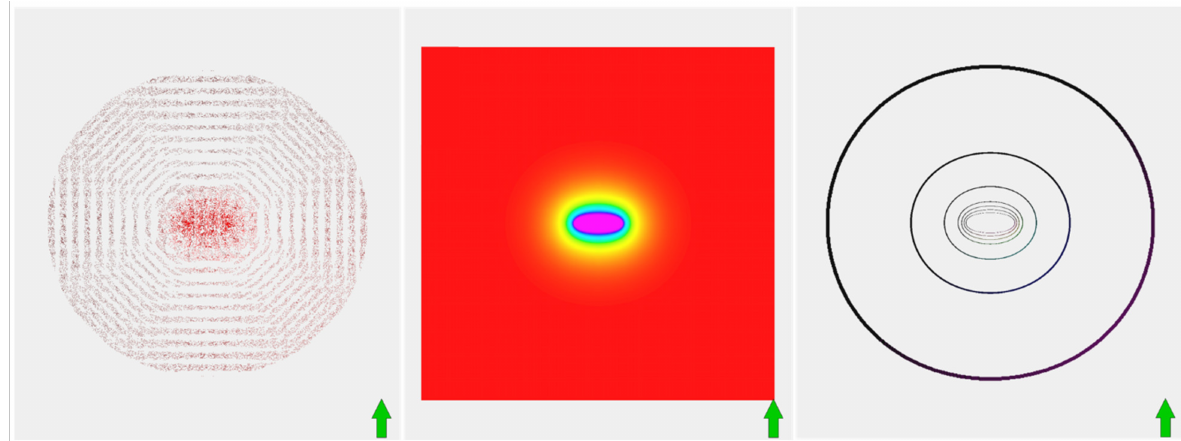
Figure 11. Pseudo-Radial Flow in Late